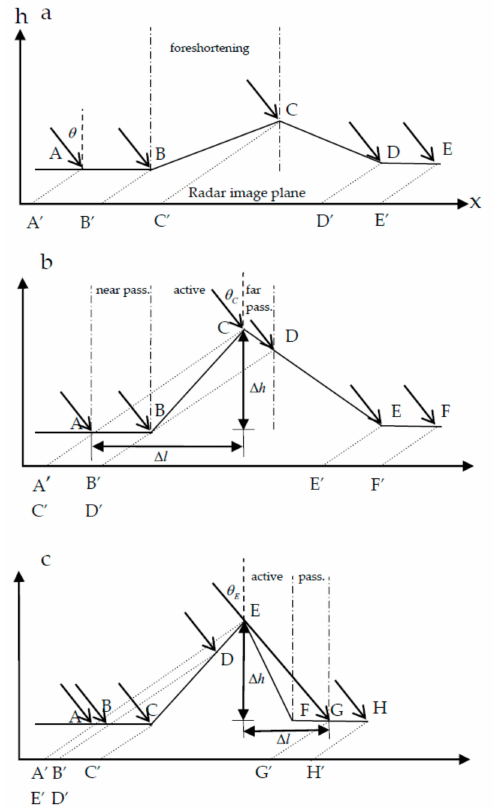
Figure 1. Illustrations of foreshortening ( a ), layover ( b ), and shadow ( c